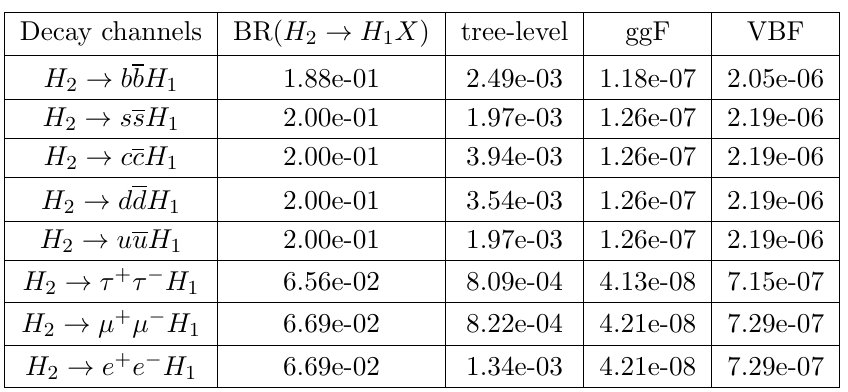
Table 2 . BR and cross sections (in pb units) for di(cid:11)erent processes for m DM = 54 GeV in scenario A50.